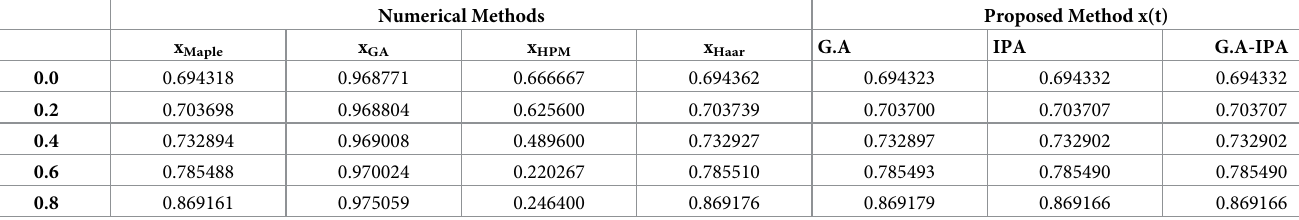
Table 15. Approximate solutions by numerical methods and proposed method for δ = 2.0.